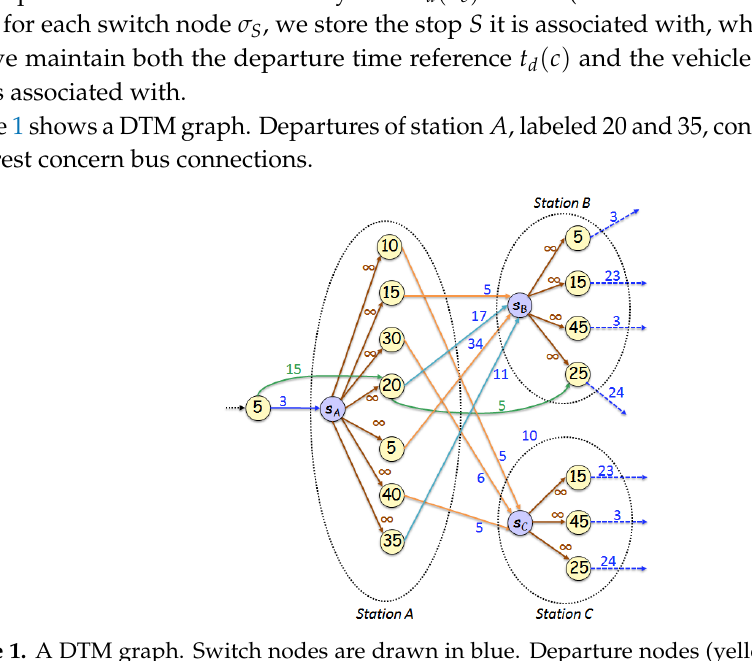
Figure 1. A DTM graph. Switch nodes are drawn in blue. Departure nodes (yellow) are associated with the departure time of their corresponding elementary connection, and are ordered by arrival time at the (arrival) station. Switch arcs are drawn in brown, while vehicle arcs are drawn in